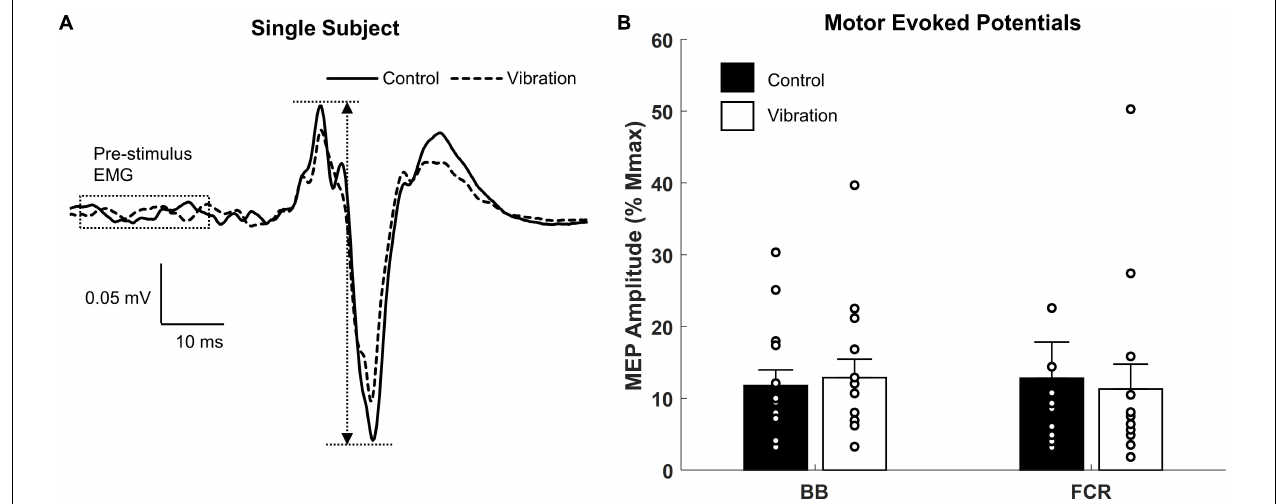
FIGURE 6 | Effects of upper limb vibration on motor evoked potentials (MEPs). (A) Single subject traces which show representative examples of MEPs during CONTROL and ULV. Solid traces indicate the average of 20 sweeps during CONTROL, whereas dotted traces indicate the average trace during ULV. (B) Group average of motor evoked potentials during CONTROL and ULV in the flexor carpi radialis and biceps brachii muscles. All single subject data is included as clear